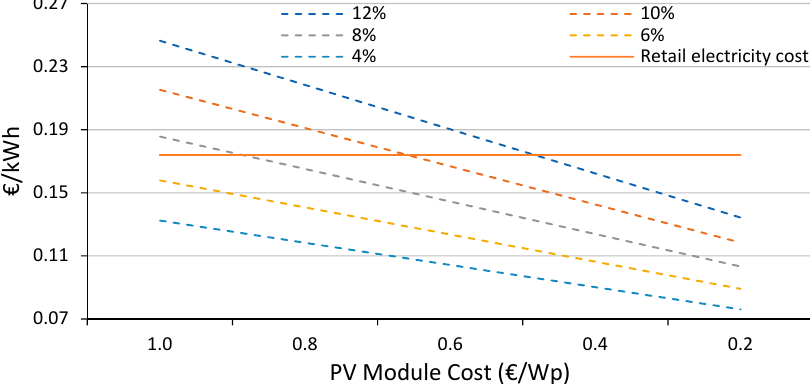
Table 10. Comparison of the LCOE based on the different annual yield for 50 kW. LCOE (€/kWh) PV Module Cost (€/Wp)